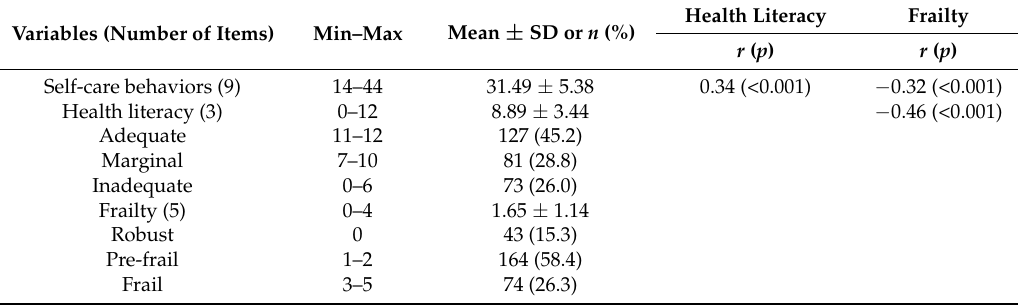
Table 3. Descriptive statistics and correlations among health literacy, frailty, and self-care scores in patients with heart failure (HF) ( n = 281).